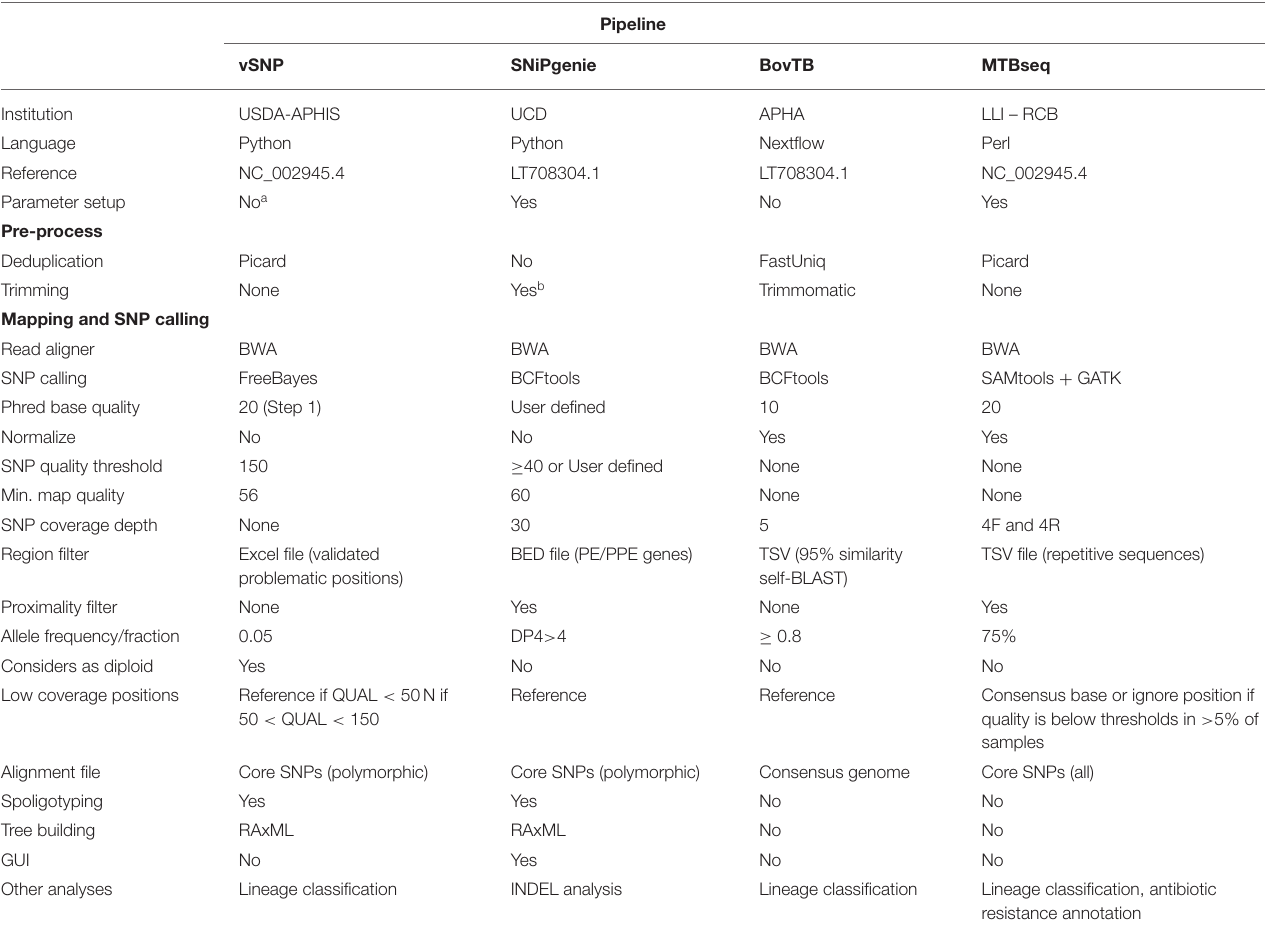
TABLE 1 | Pipeline properties of the different tools evaluated in this